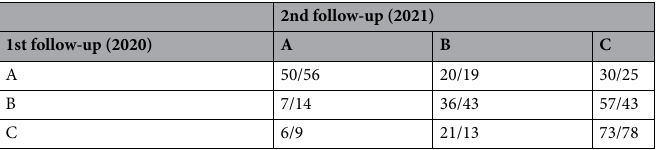
Table 2. Associations between 1st and 2nd follow-up (percentage − general vaccination attitudes/willingness for SARS-CoV-2 vaccination). A—Always anti or developed general negative attitudes towards vaccinations recommended/certainly not or unlikely taking SARS-CoV-2 vaccine; B—Unchanged attitudes towards recommended vaccinations/not known yet towards a SARS-CoV-2 vaccine; C—Always pro or developed positive attitudes towards recommended vaccinations/probably or with certainty taking the SARS-CoV-2 vaccine. Meaning of percentages in a field—example field A/A: 50% of those MS-patients with a negative attitude towards general vaccination recommendations during the 1st follow-up had also a negative attitude during the 2nd follow-up; 56% of those with a negative attitude towards a SARS-CoV-2 vaccination during the 1st follow-up had still a negative attitude at the 2nd